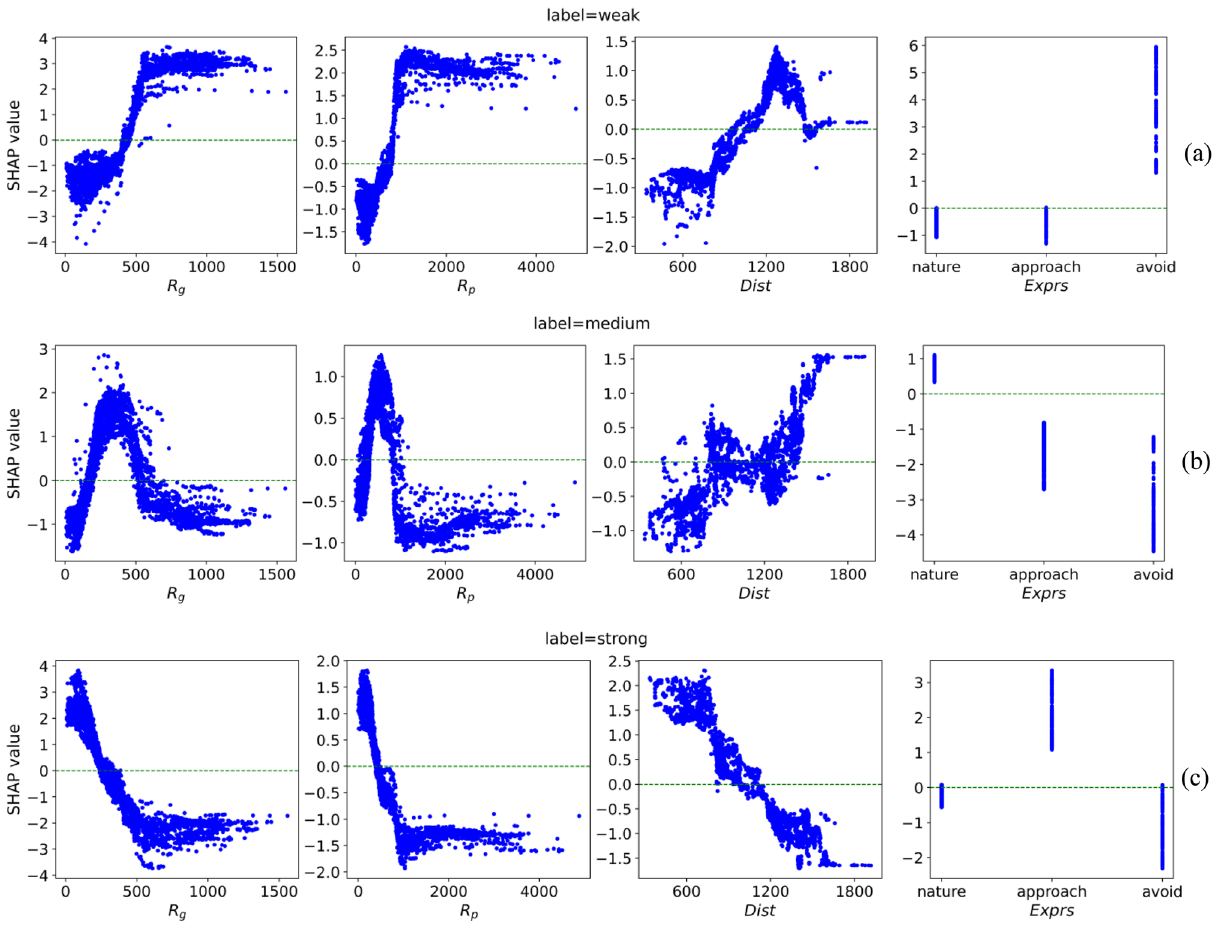
Figure 8. Distribution of the shape values of R g , R p , Dist and Exprs under different IHEI labels (i.e., strong, medium, and weak). ( a ) Weak HIE intensity. ( b ) Medium HIE intensity. ( c ) Strong HIE intensity.